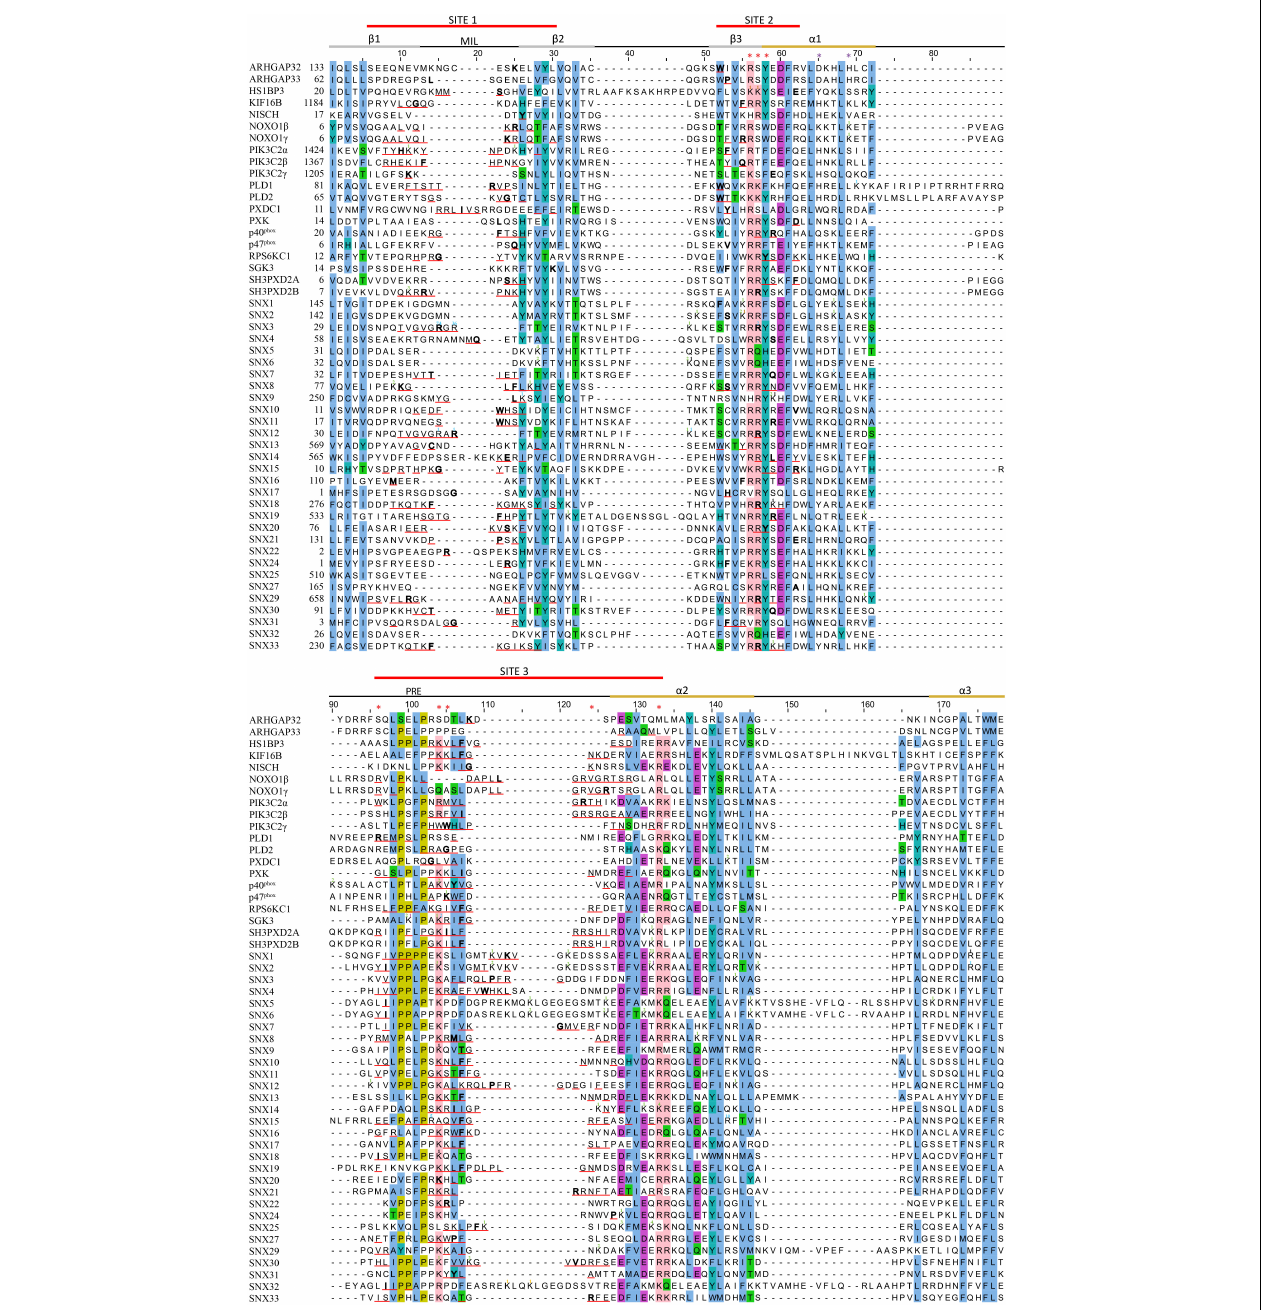
FIGURE 5 | Sequence alignment of all human PX domains. Citations of acetylated, butyrylated, glycated, malonylated, methylated and succinylated residues are indicated with a green, brown, orange, black, blue and purple superscript, respectively. The secondary structure, membrane insertion loop (MIL) and proline rich element (PRE) are indicated below the three red-lined membrane docking sequences. PIP headgroup and phosphatidic acid binding positions are indicated with red and purple asterisks, respectively. The residue with the highest MODA score in each site is bolded. Aligned conserved hydrophobic, proline, polar, acidic, and basic residues are highlighted in blue, olive, green, purple, and